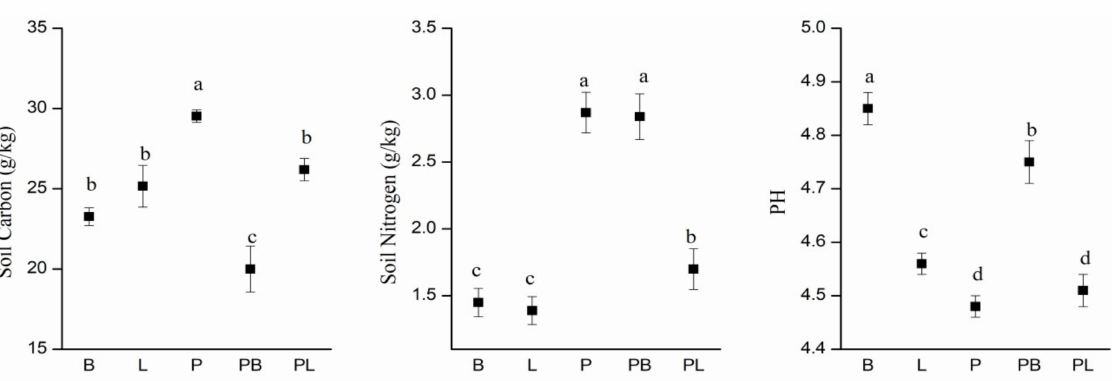
Figure 5. Variations of soil physicochemical features among monocultures and mixed-species plantations. Different lowercase letters represent significant differences, p < 0.05.